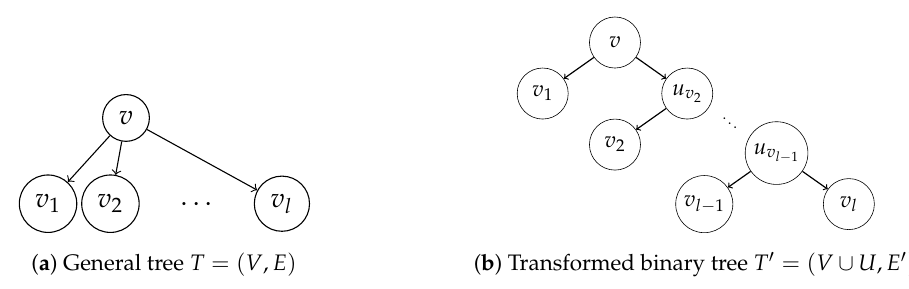
Figure 3. Example of transformation from general tree to binary